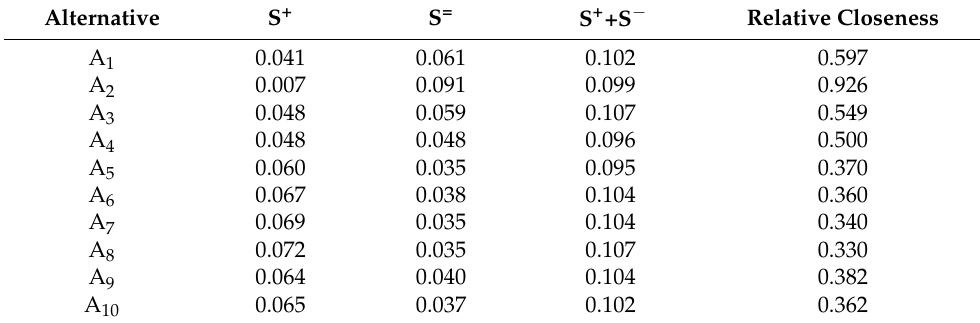
Table 9. Relative Closeness.